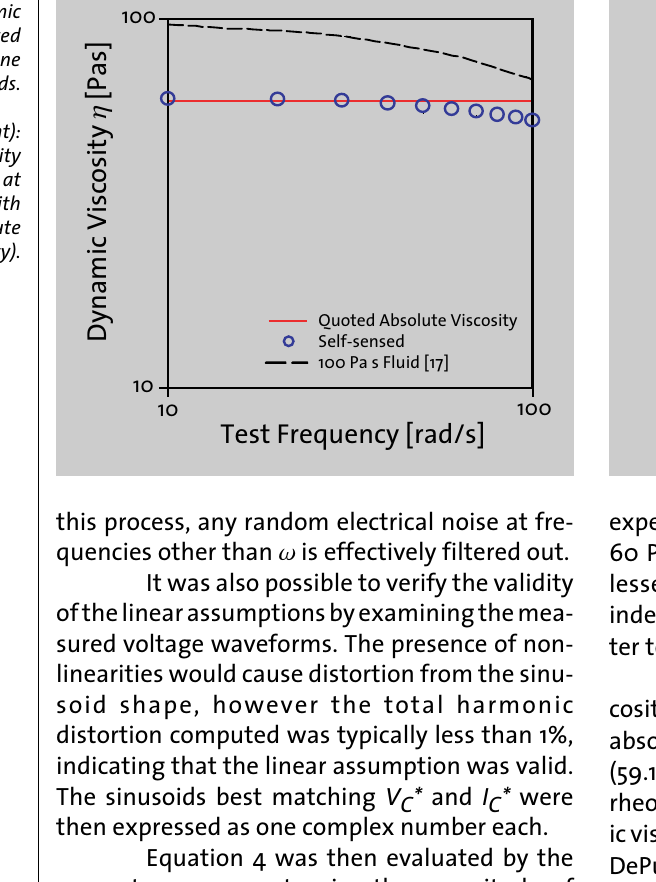
Figure 5 (left): Estimated in-phase dynamic viscosity and quoted absolute viscosity of silicone fluids. Figure 6 (right): Estimated dynamic viscosity of CMW1 bone cement at 10 rad/s (compared with studies of absolute viscosity).